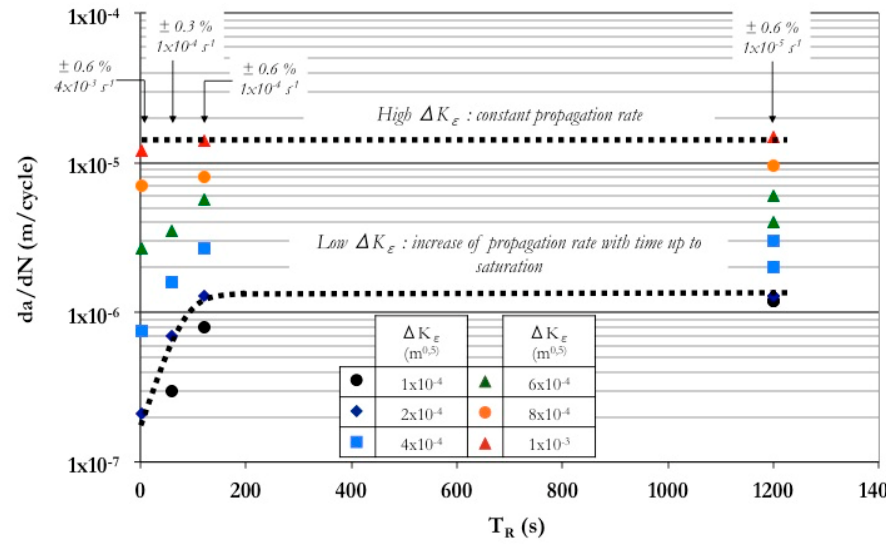
Figure 14. Fatigue crack growth rates as a function of the T R parameter for selected ∆𝐾 (cid:2965)